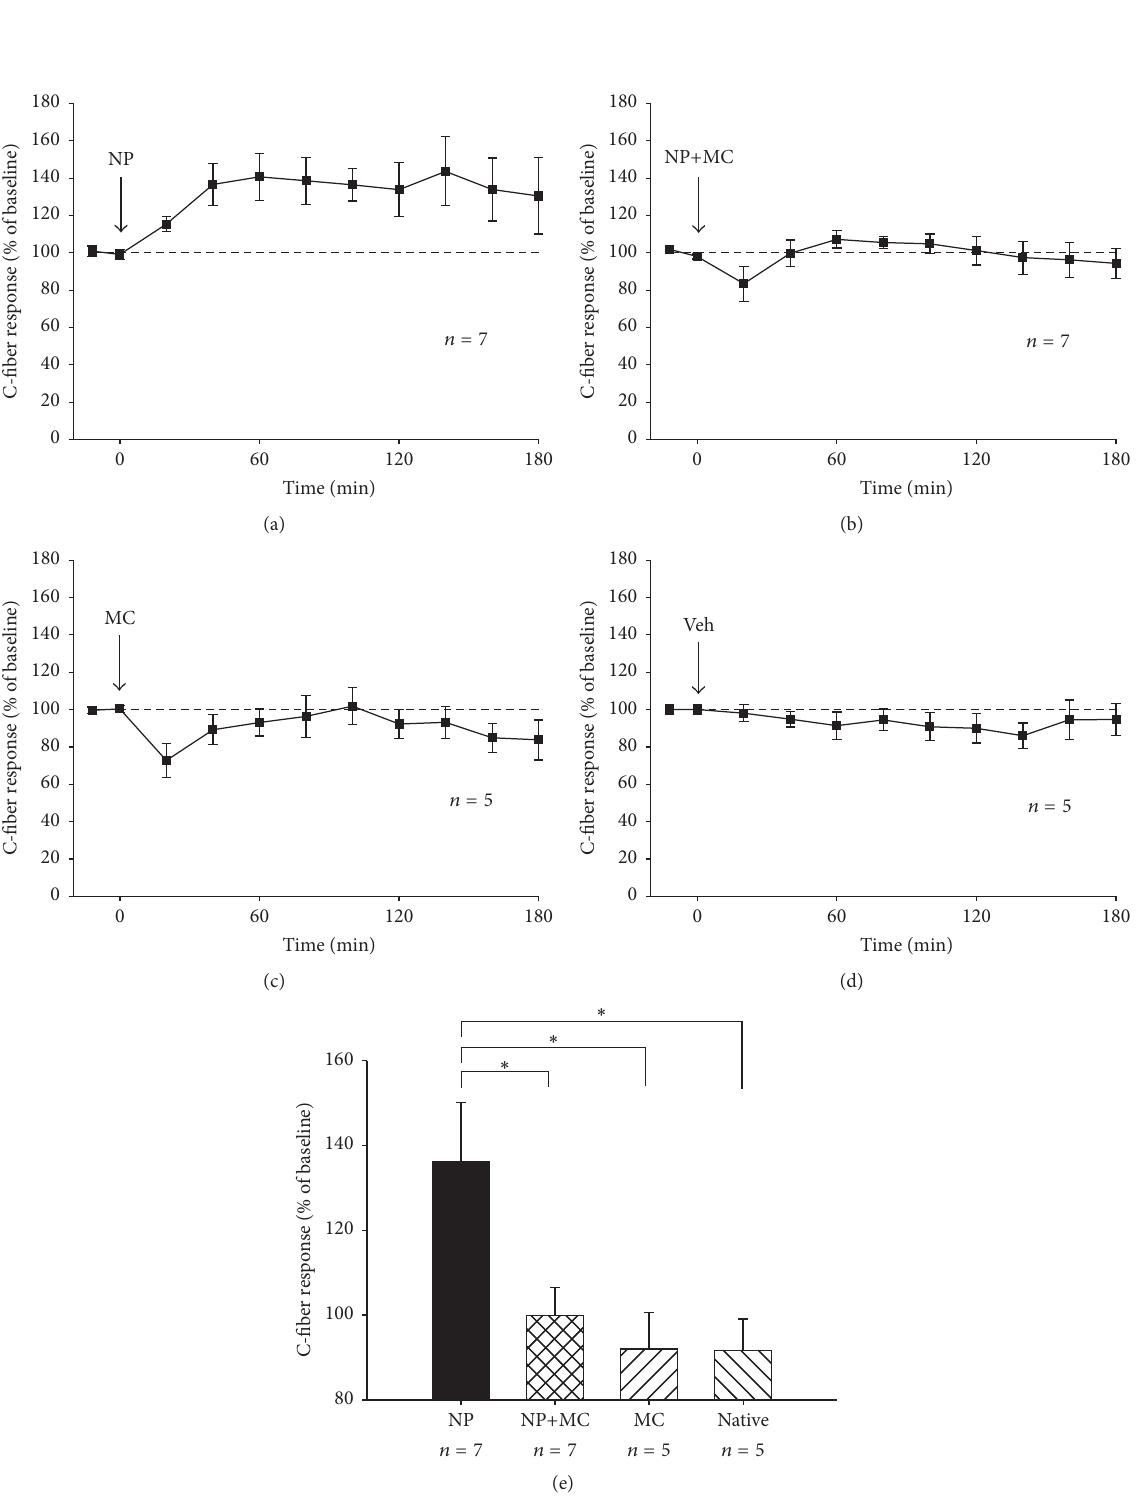
Figure 2: C-fiber response in percent of baseline after application of (a) NP (NP), (b) NP and minocycline (NP+MC), (c) minocycline (MC), and (d) Vehicle (Veh). (e) The mean value 60 to 180 minutes after baseline in the four groups. 𝑃 = 0.018 , rmANOVA, four groups; NP, NP+MC, MC, Veh. ∗ 𝑃 < 0.05 , one-way ANOVA, Tukey’s post hoc